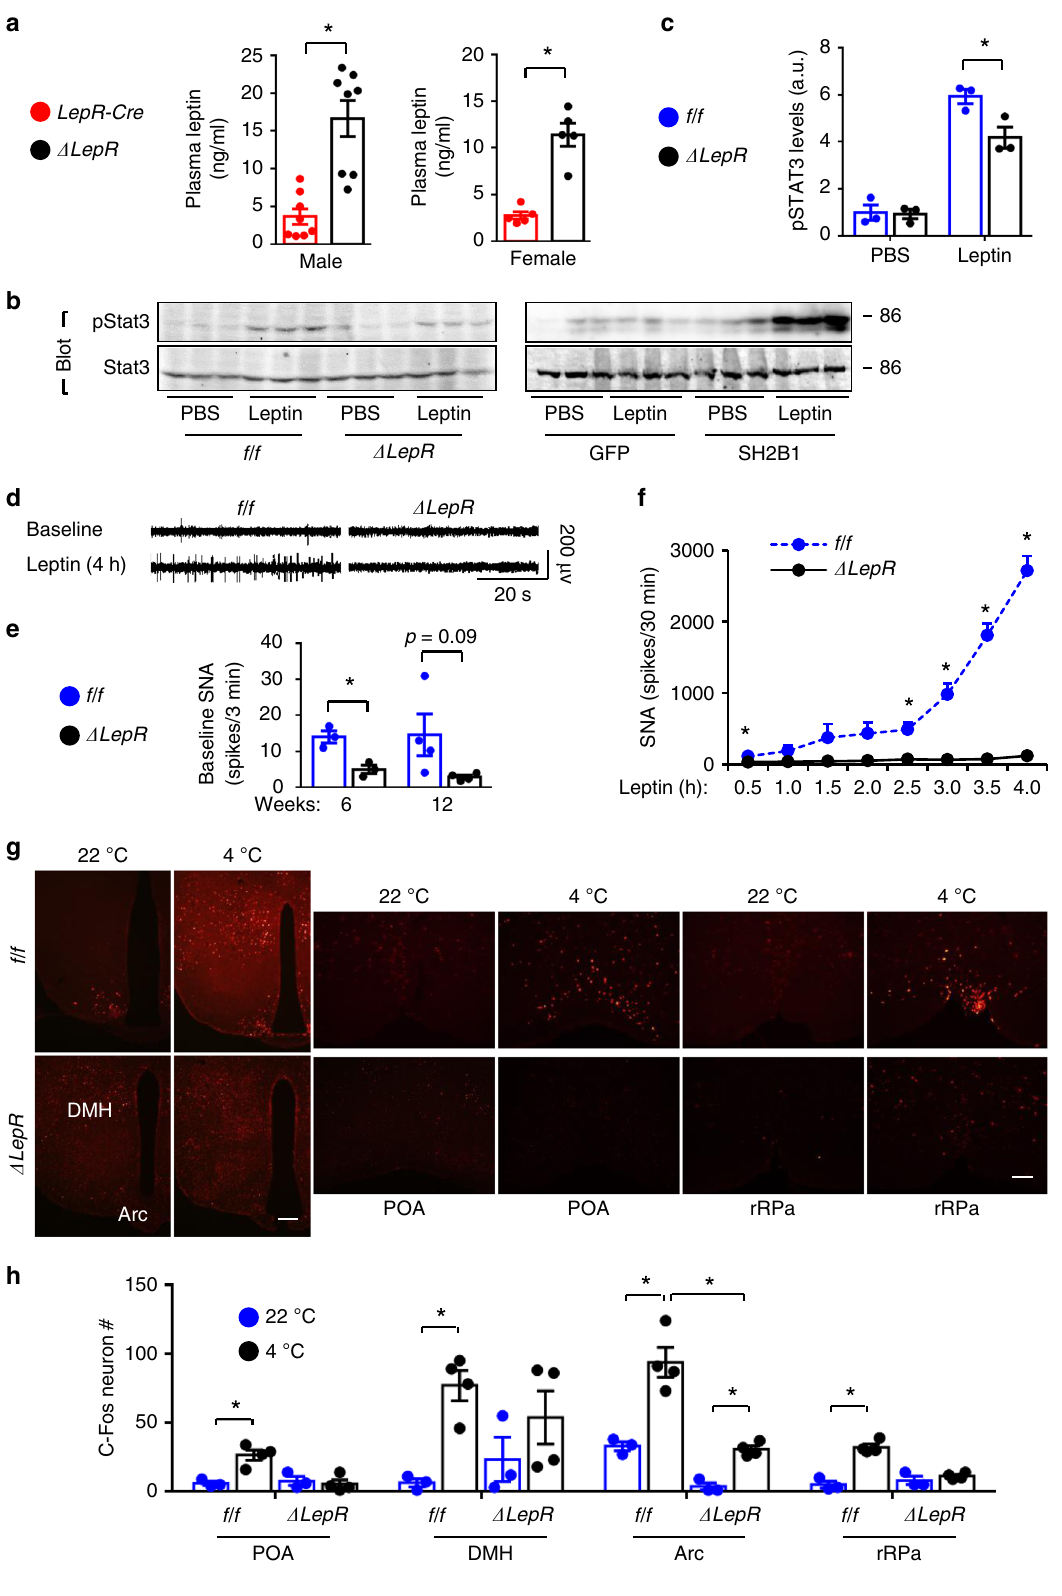
unrecognized Sh2b1/hypothalamic sympathetic network/SNS/ BAT energy expenditure axis. LepR neuron Sh2b1 preserves adipose SNS integrity in aging . Sh2b1 Δ LepR mice develop obesity in an age-dependent manner,